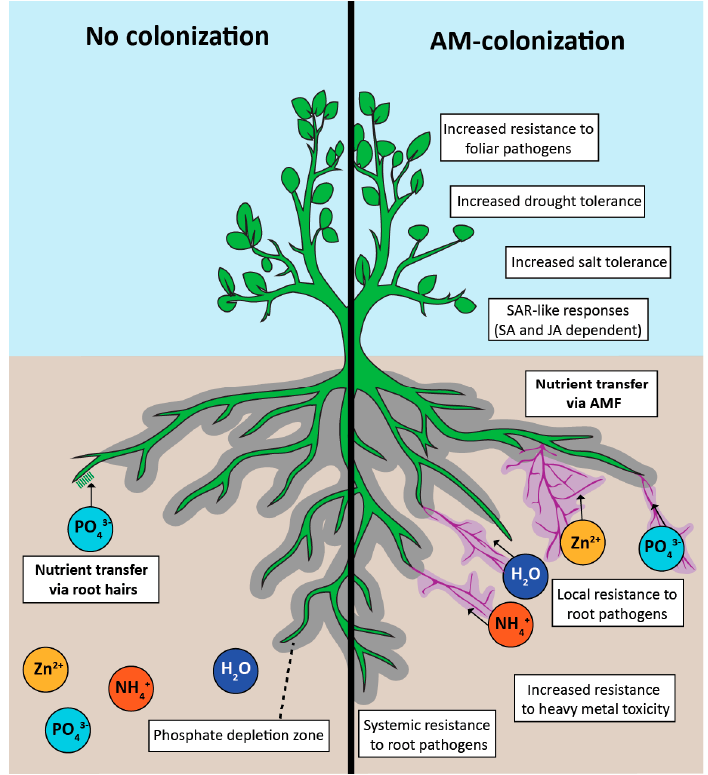
Figure 1. Positive effects of arbuscular mycorrhizal (AM) colonization. The hyphal network of arbuscular mycorrhizal fungi (AMF) extends beyond the depletion zone (grey), accessing a greater area of soil for phosphate uptake. A mycorrhizal-phosphate depletion zone will also eventually form around AM hyphae (purple). Other nutrients that have enhanced assimilation in AM-roots include nitrogen (ammonium) and zinc. Benefits from colonization include tolerances to many abiotic and biotic stresses through induction of systemic acquired resistance (SAR).